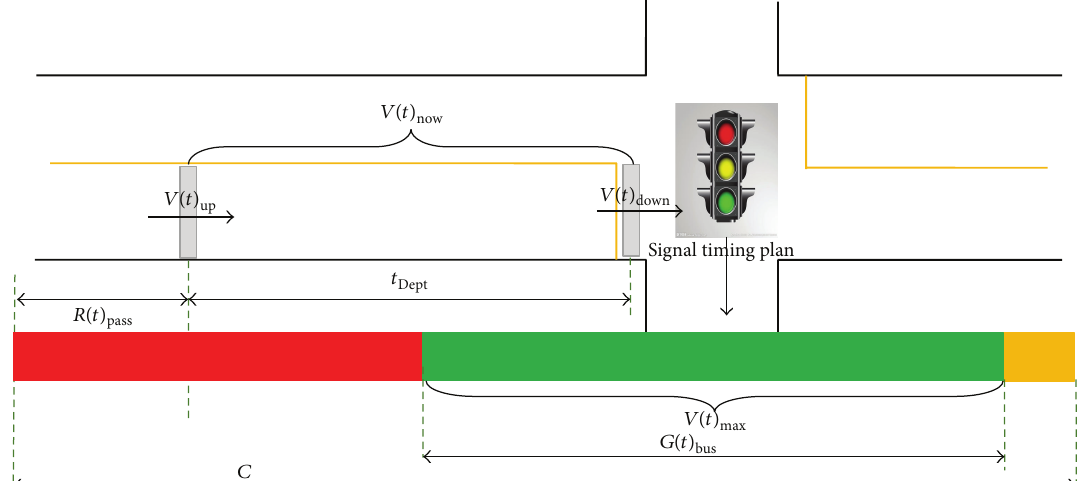
Figure 4: The signal status when transit vehicle arrives at the check-in